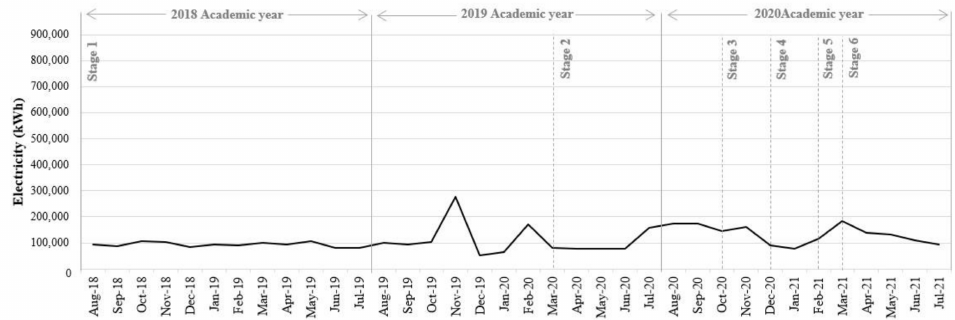
Figure A4. Electricity consumption of the residence type during AY2018 to